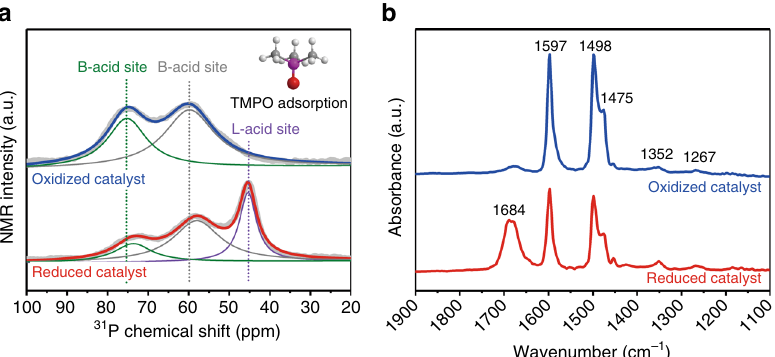
Fig. 4 Surface analyses of Pd/m – MoO 3 – P 2 O 5 /SiO 2 catalyst. a Solid-state 31 P MAS NMR spectra of TMPO-adsorbed on the oxidized catalyst and reduced catalyst (Pd/m – MoO 3 – P 2 O 5 /SiO 2 ). Inset displayed TMPO molecule. b DRIFTS spectra at 1100 – 1900 cm − 1 obtained over oxidized catalyst and reduced catalyst (Pd/m – MoO 3 – P 2 O 5 /SiO 2 ) in a reaction mixture containing phenol and He at 383 K